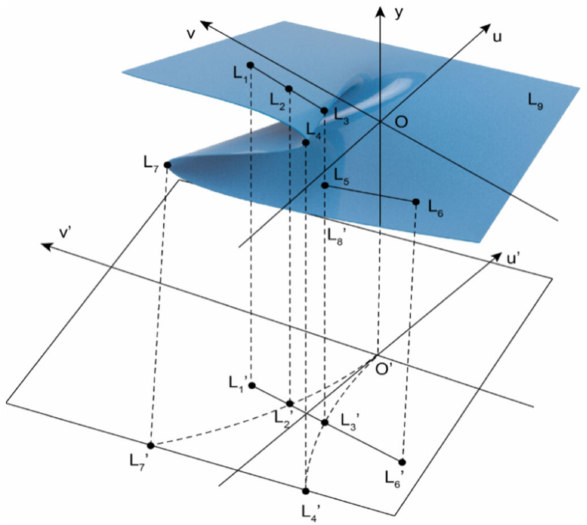
Figure 3. Evolution mechanism of risk state in cusp catastrophe